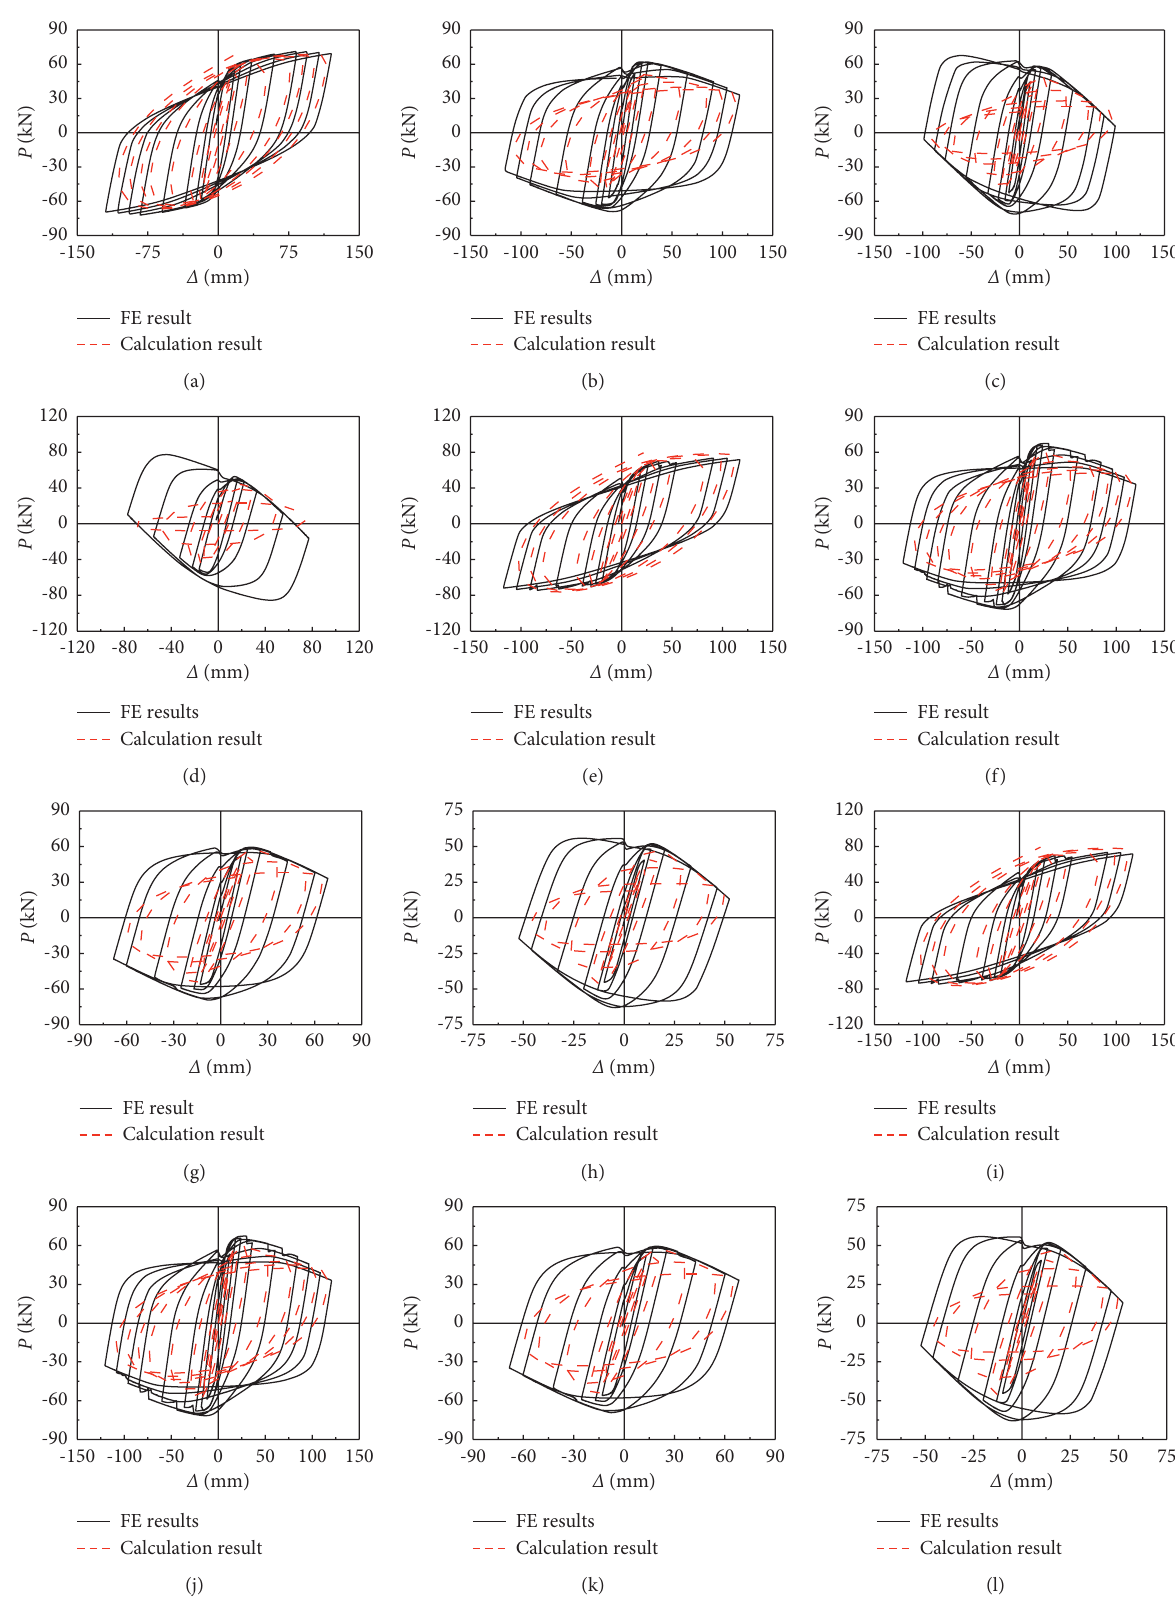
Figure 23: The comparison between the restoring force model’s results and the finite element simulation results. (a) A0 specimen. (b) B0 specimen. (c) C0 specimen. (d) D0 specimen. (e) A1 specimen. (f) B1 specimen. (g) C1 specimen. (h) D1 specimen. (i) A2 specimen. (j) B2 specimen. (k) C2 specimen. (l) D2